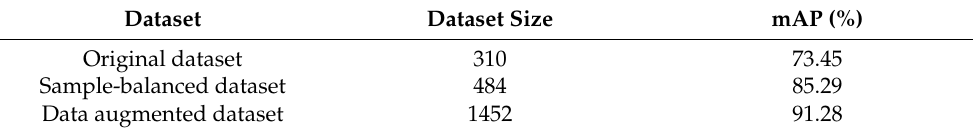
Table 4. Maximum accuracy performance on the test set for data sets of different sizes.